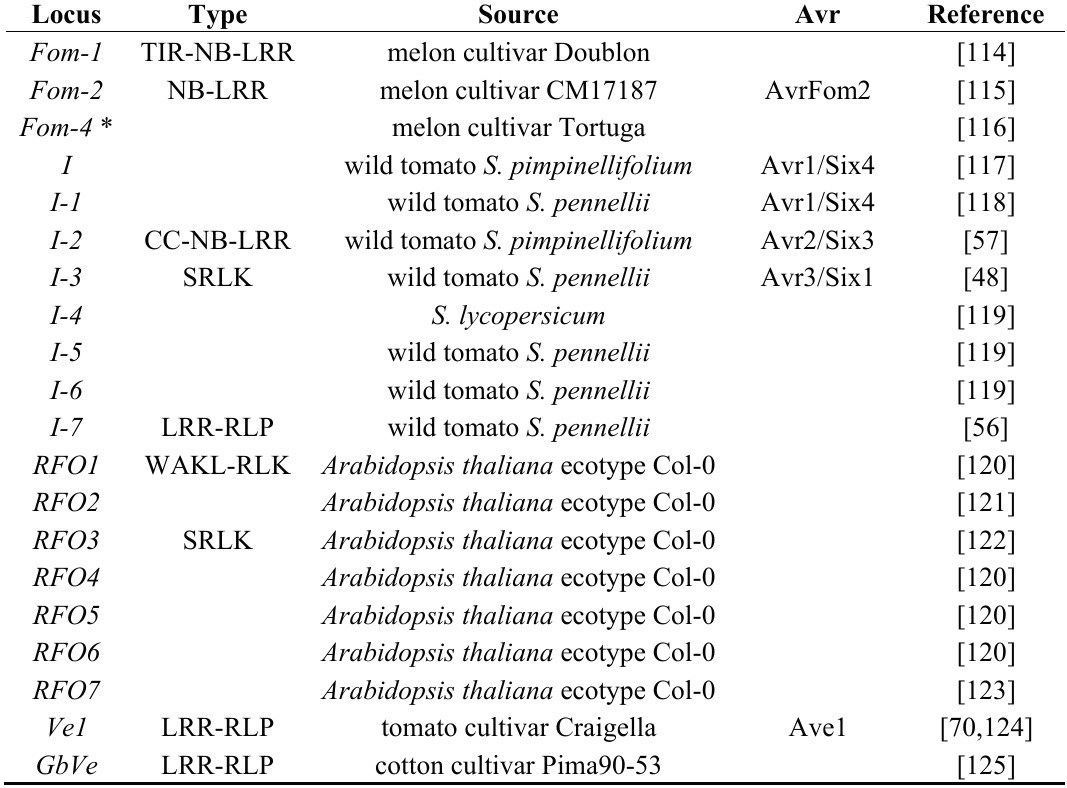
Table 2. Receptor proteins involved in resistance against vascular wilt